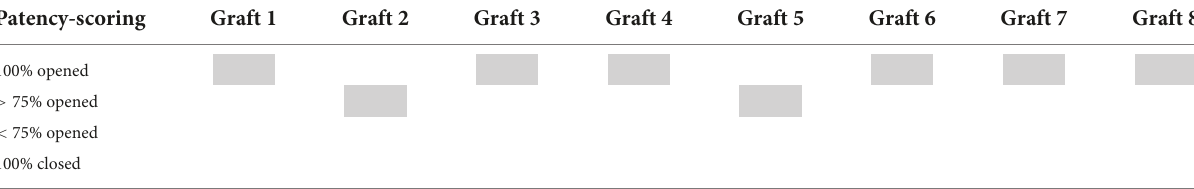
TABLE 2 Coronary angiography 4 weeks after coronary artery bypass grafting (CABG) (scoring). Patency-scoring Graft 1 Graft 2 Graft